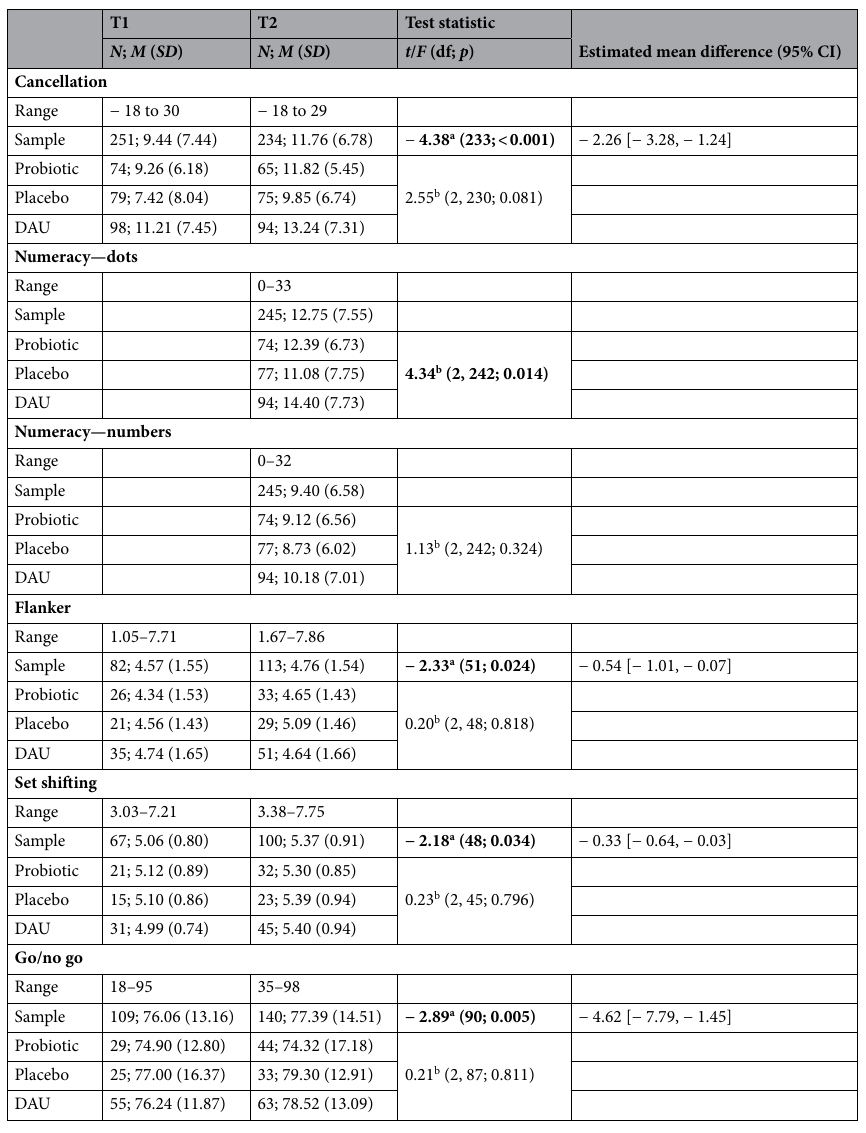
Table 3. Descriptive statistics by group, tests of improvement over time, and group effects. a Paired samples t-test comparing scores at T2 with those of T1 for the group as a whole; b ANCOVA examining group difference in T2 scores with T1 scores included as covariate (except